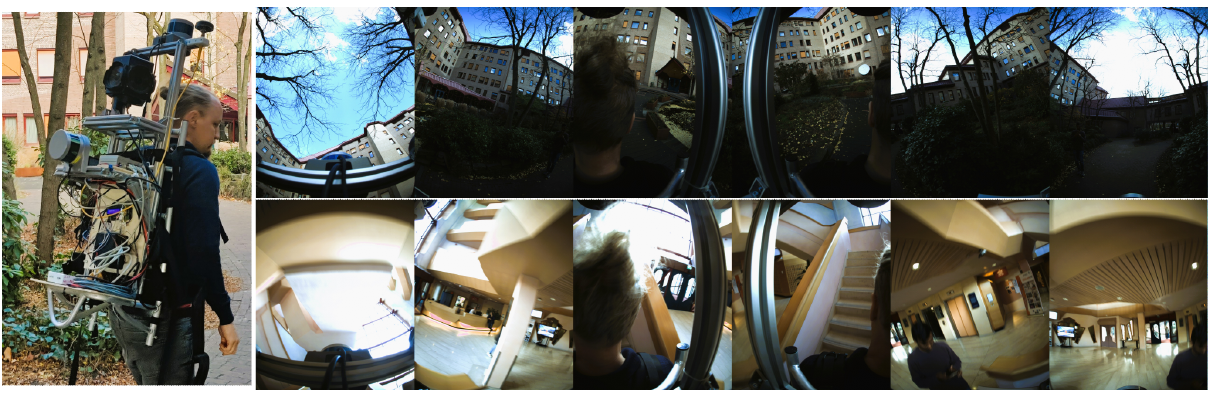
Figure 6: A panoramic Ladybug5+ camera mounted on a multi-sensor backpack system designed by the first author at the University of Twente (left). Images acquired with the Ladybug5+ camera array outdoors (top) and indoors (bottom) show an overlap and barrel distortion. Camera direction is up, right, front right, front left, left, back.